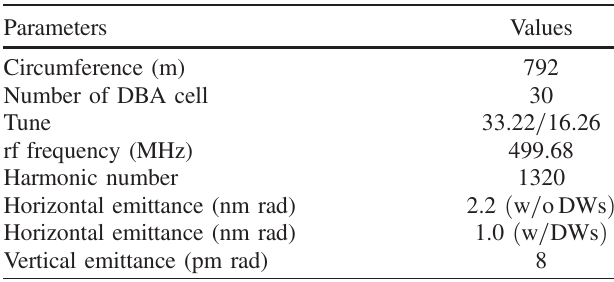
TABLE I. Main parameters of NSLS-II ’ s